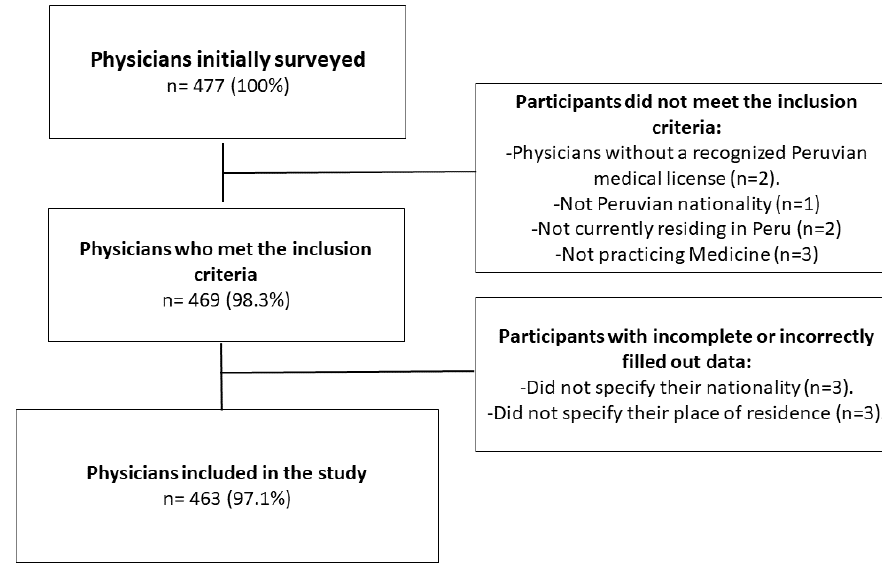
Figure 1. Flowchart of the participants’ selection. n: number. Table 1. Characteristics of the participants.